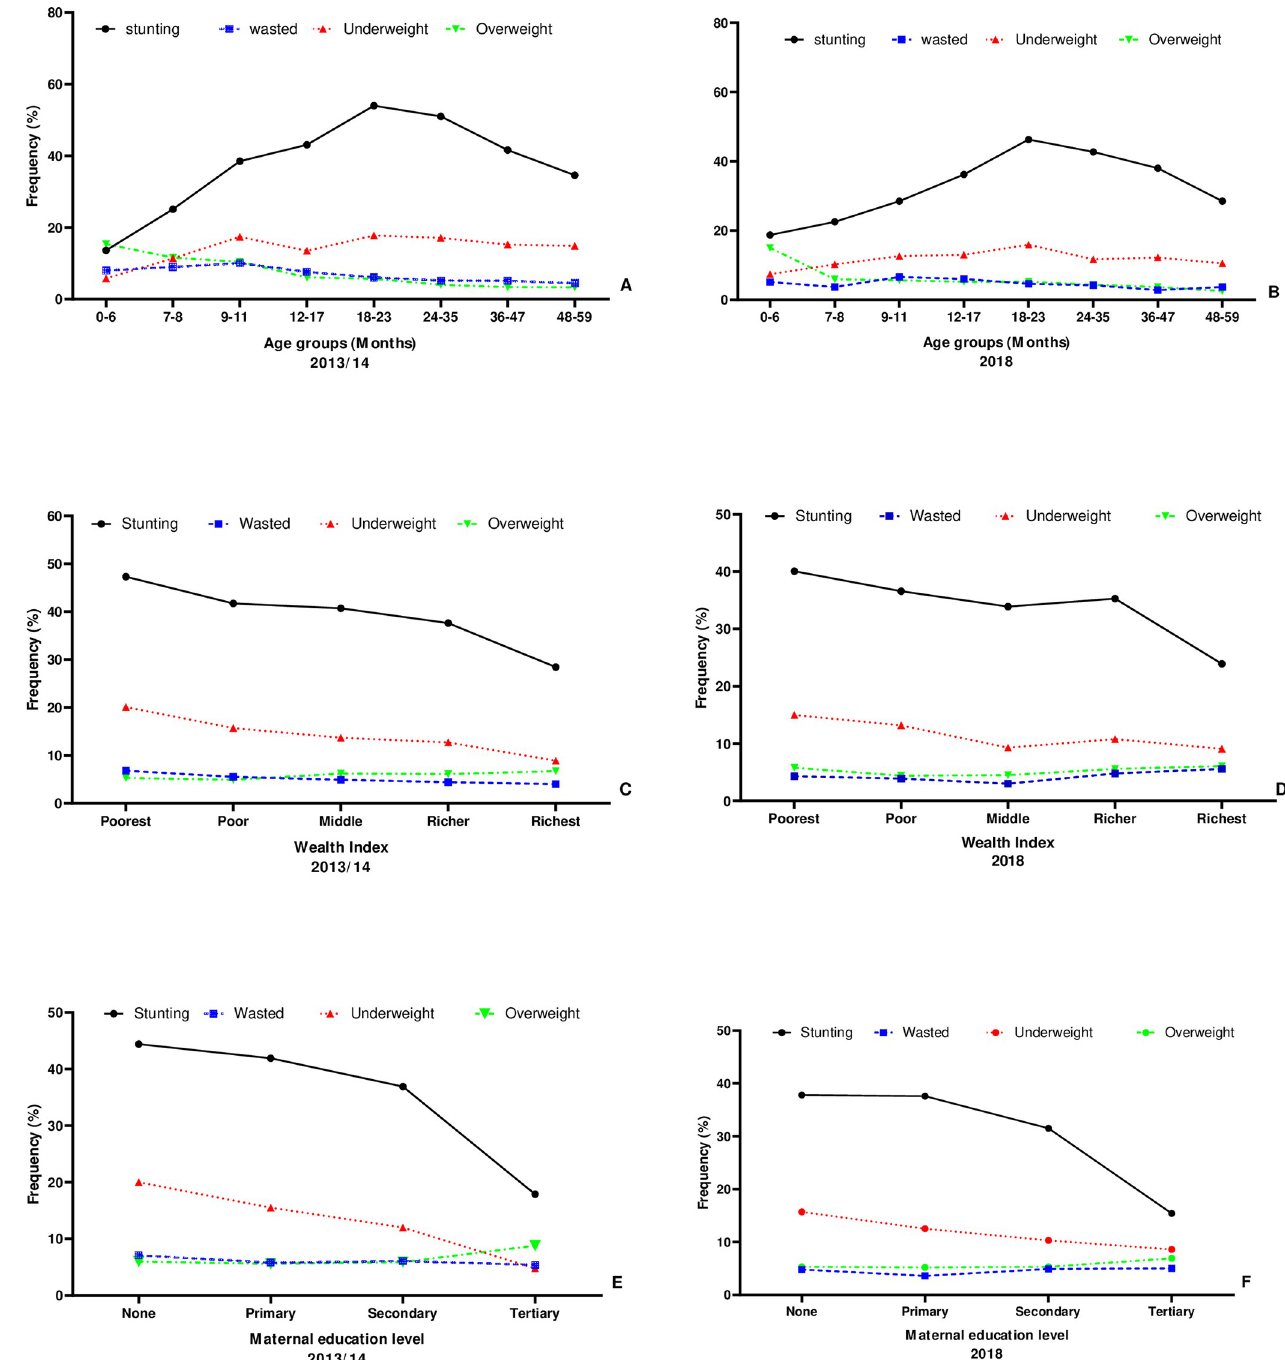
Fig 1. Trends of malnutrition Indicators by (A) Age in 2013/14 (B) Age in 2018 (C) Wealth Index 2013/14 (D) Wealth Index 2018 (E) Maternal education level in 2013/14 (F) Maternal education level in 2018. (Source: author generated map).